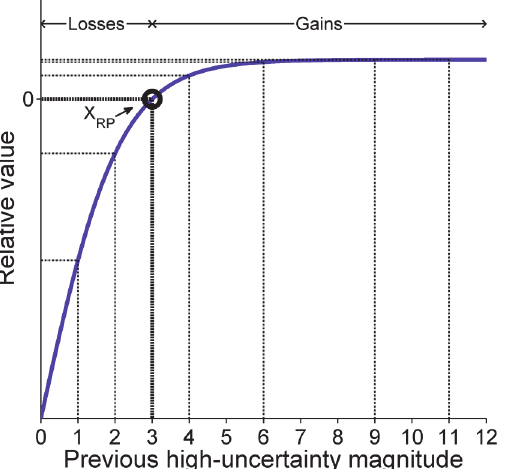
Fig 12. A proposed mechanism to account for the asymmetric effects of previous high-uncertainty choice outcomes on subsequent choice behavior. The abscissa is the magnitude of the previous high- uncertainty outcome. The ordinate is the subjective value of the previous high-uncertainty outcome relative to the value of the low-uncertainty outcome choice (e.g., 3 food pellets). The low-uncertainty outcome reference ( X RP ) differentiates gains and losses for the high-uncertainty